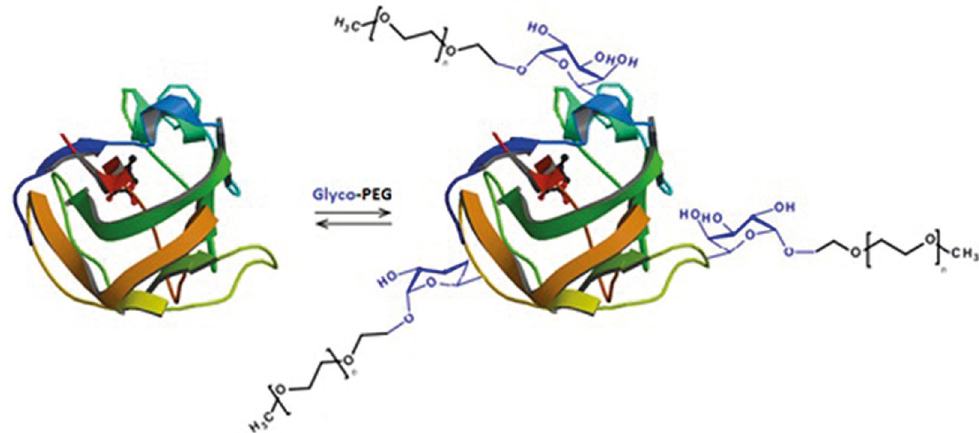
FIGURE 9 - Schematic representation of a reversible PEGylation with